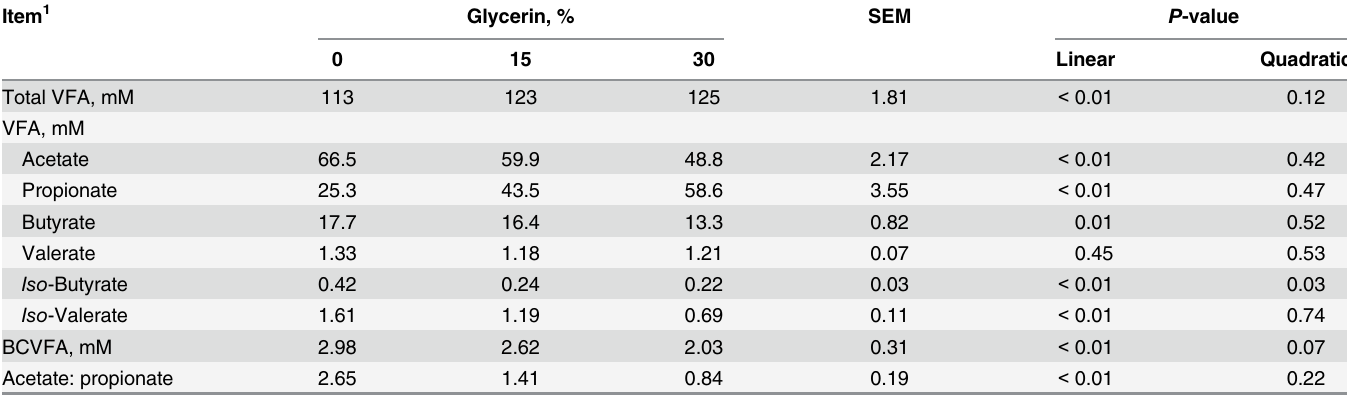
Table 3. Effect of glycerin inclusion on total and individual VFA concentrations in dual-flow continuous culture system. Item 1